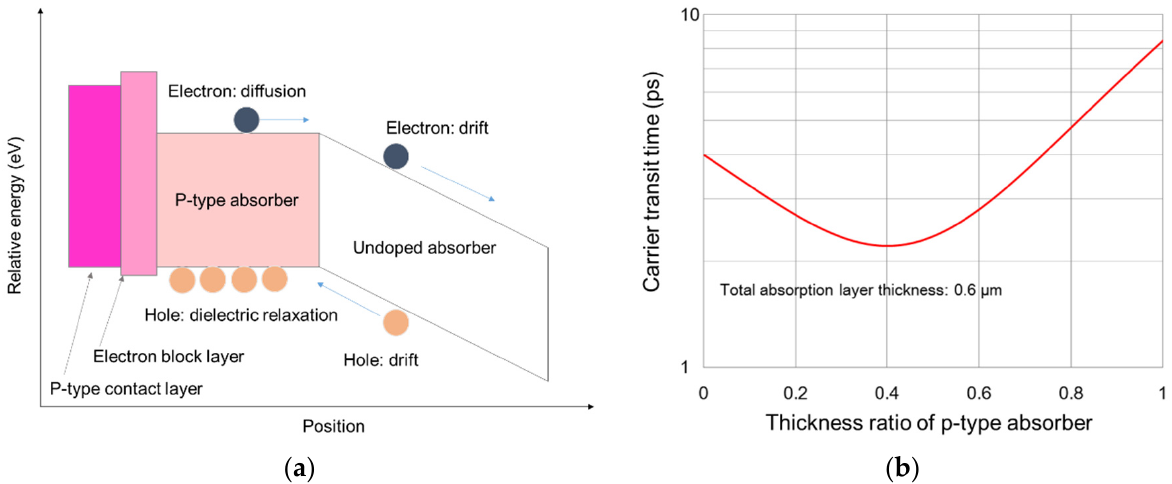
Figure 1. ( a ) schematic band diagram of a hybrid absorber and ( b ) calculated carrier transit time against various thickness ratios of a p-type absorber to an entire hybrid absorber.